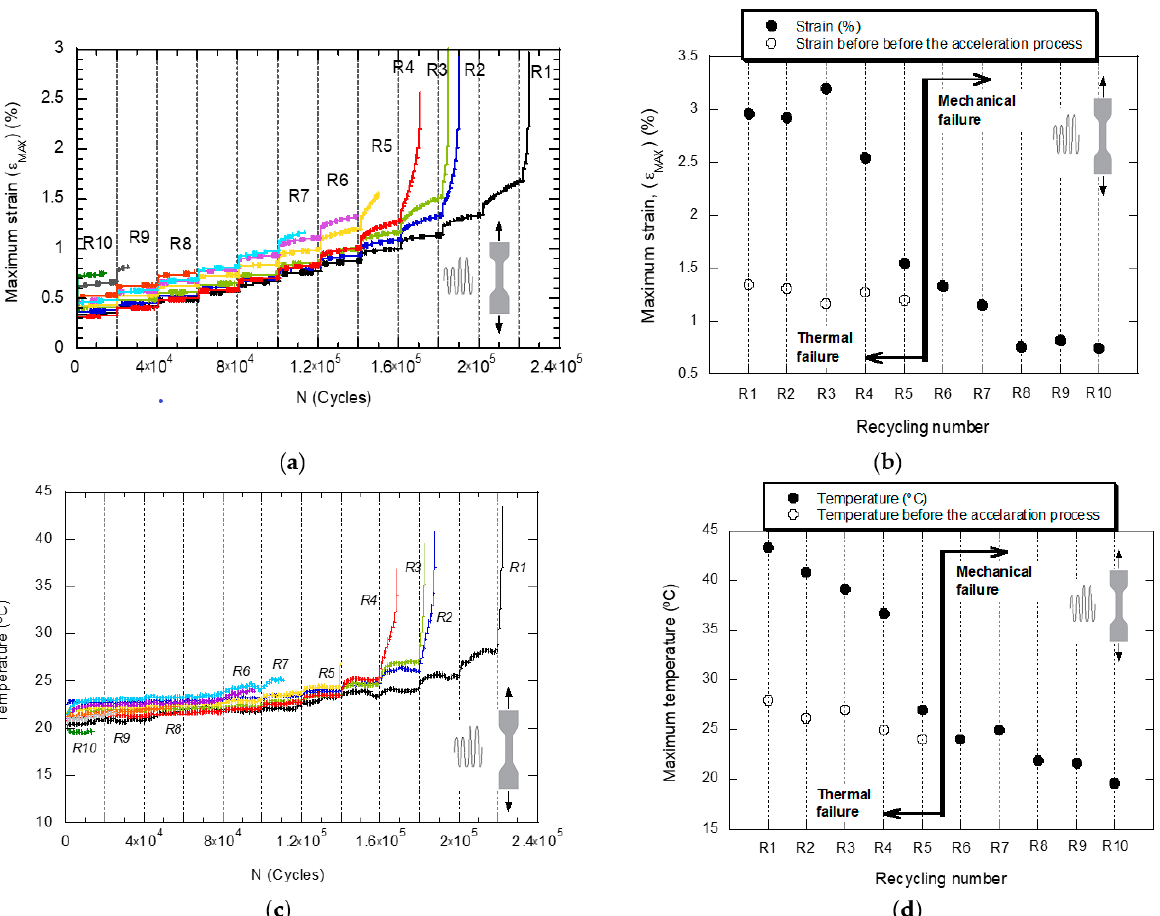
Figure 7. Evolution of the maximum strain, ε MAX , as a function of (( a ) the number of fatigue cycles applied in the LOCATI test for the different material conditions (R1 to R10, ( b ) the recycling number) and evolution of the surface temperature of the sample as a function of (( c ) the number of fatigue cycles applied in the LOCATI test for the different material conditions (R1 to R10) and ( d ) the recycling number).